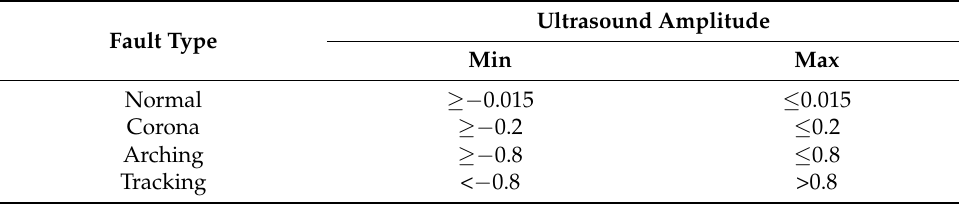
Table 2. The expert rule based on the time domain ultrasound